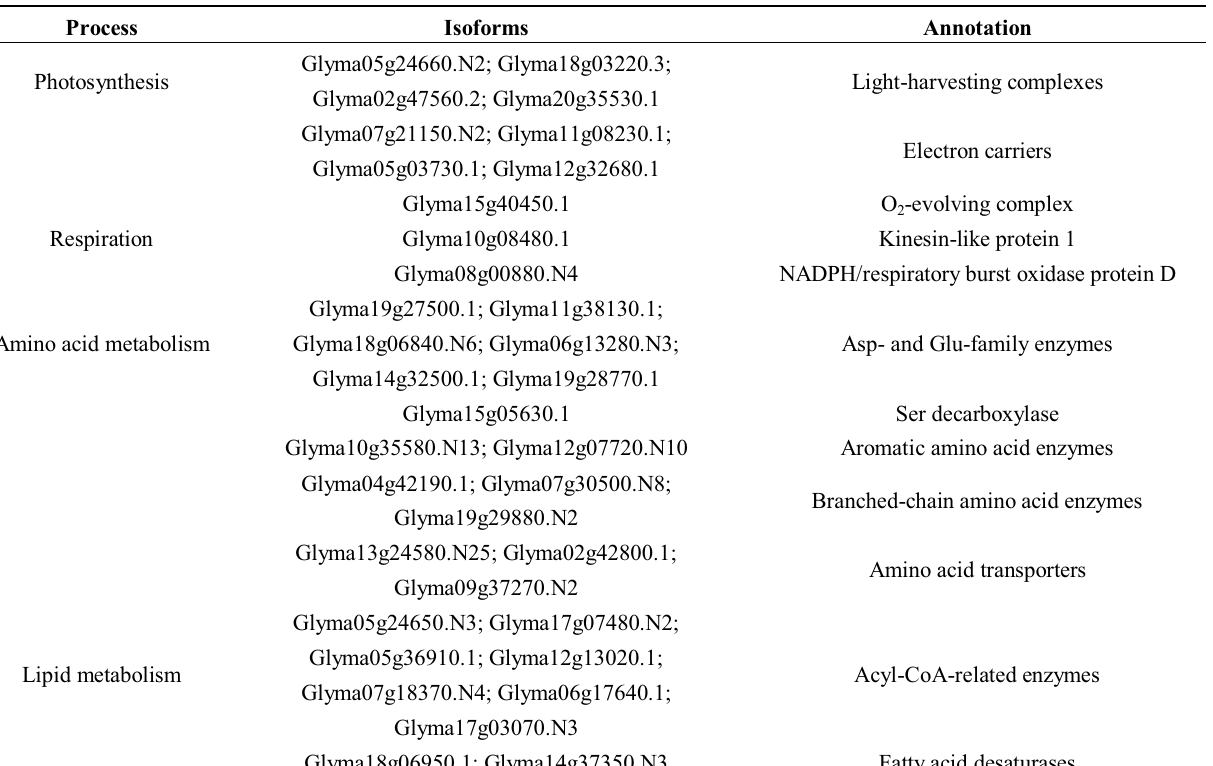
Table 3. Isoforms present in clusters 27, 28, 37, 38, 43, 45, 47, and 52 representing central carbon and nitrogen metabolism (CCNM) supporting seed filling. Amino acid and lipid metabolism is dominating these